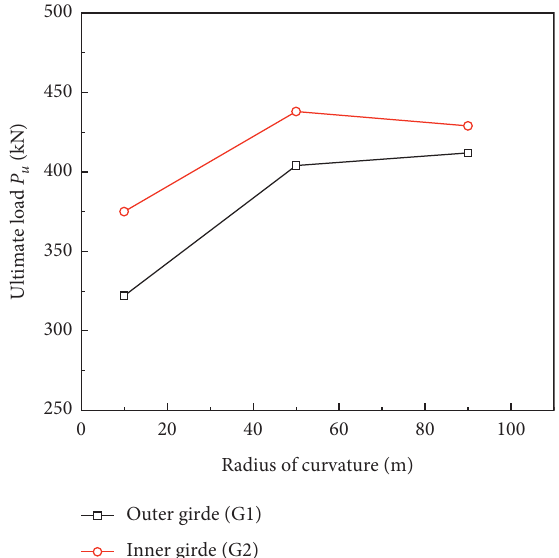
Figure 15: Relationship between ultimate load and radius of curvature.